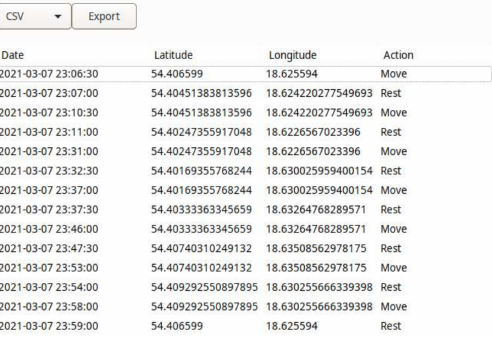
Figure 8. Movement